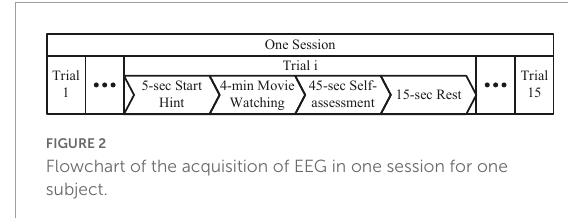
of eliciting positive, neutral, or negative emotions. The number of movie clips was the same for each emotion; in other words, each emotion corresponded to roughly the same number of samples. The flowchart of EEG acquisition is shown in Figure 2